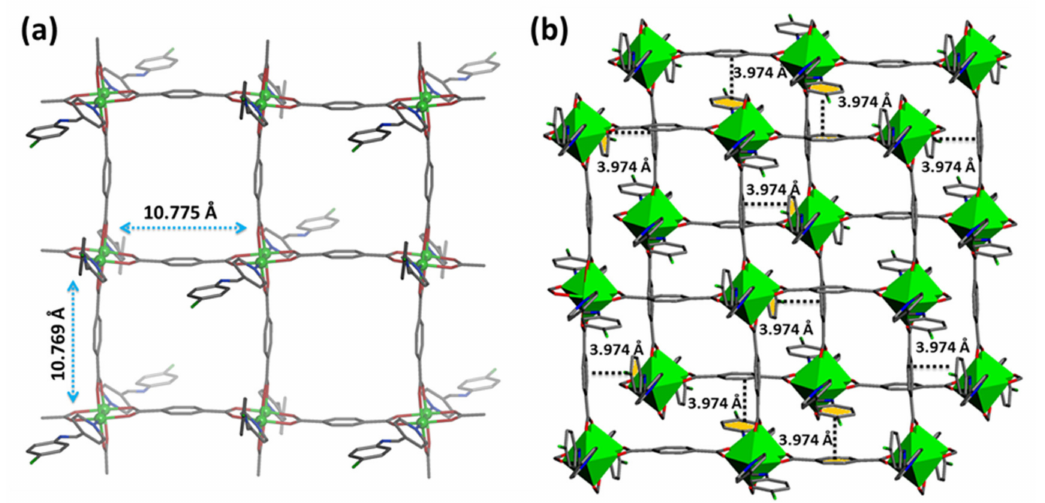
Figure 3. ( a ) a portion of the (4,4) net structure and ( b ) a perspective view of the 3D supramolecular aggregate of Cu-MOF by π – π